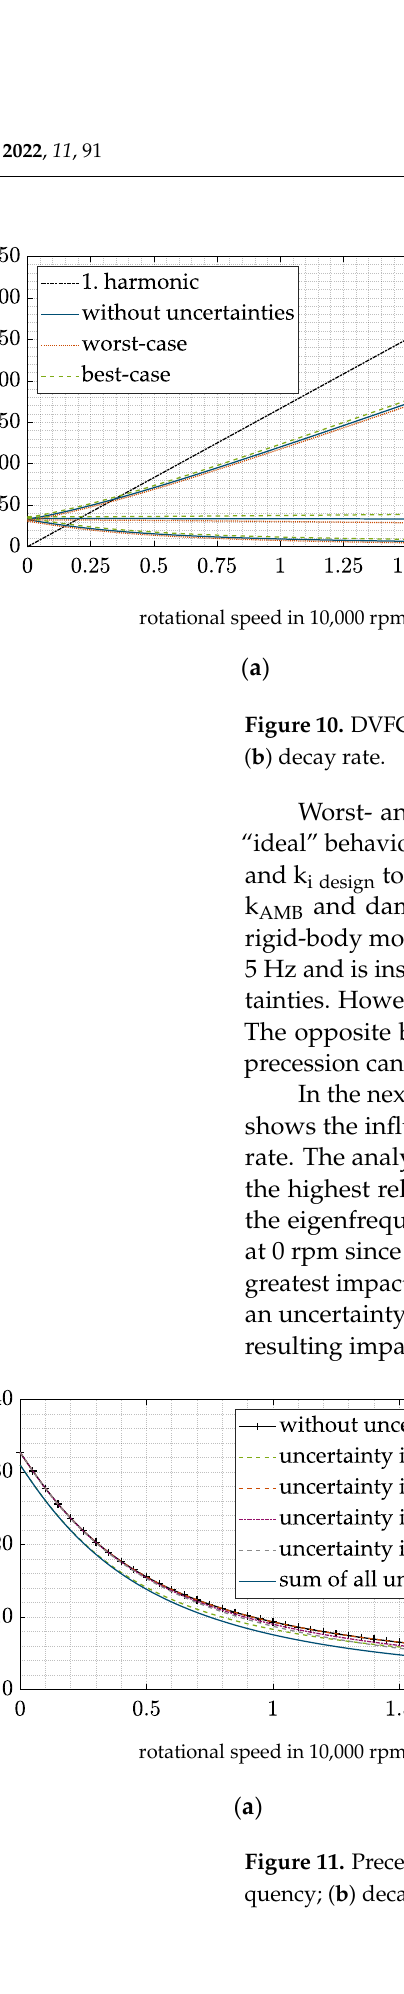
Figure 11. Precession mode with DVFC for worst-case combination of all uncertainties: ( a ) eigenfrequency; ( b ) decay rate.